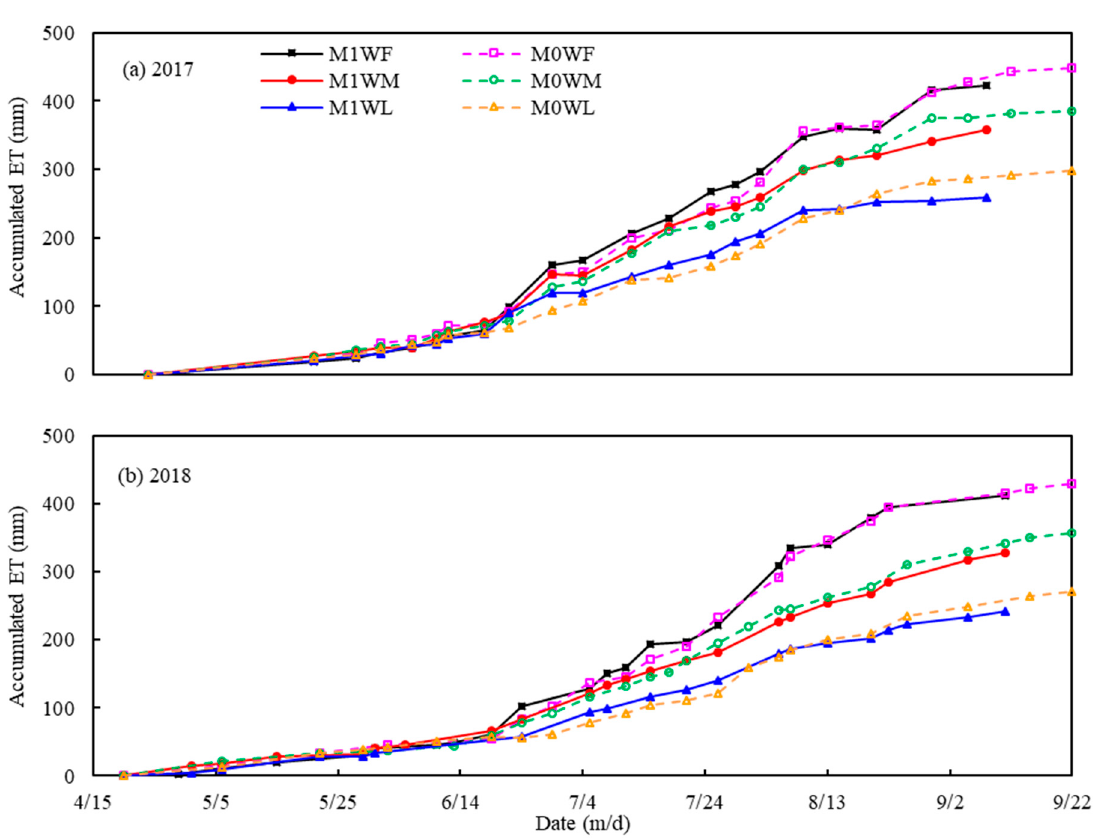
Figure 6. The measured accumulated ET using the water balance method for all the treatments during the entire growing period in 2017 ( a ) and 2018 ( b ).